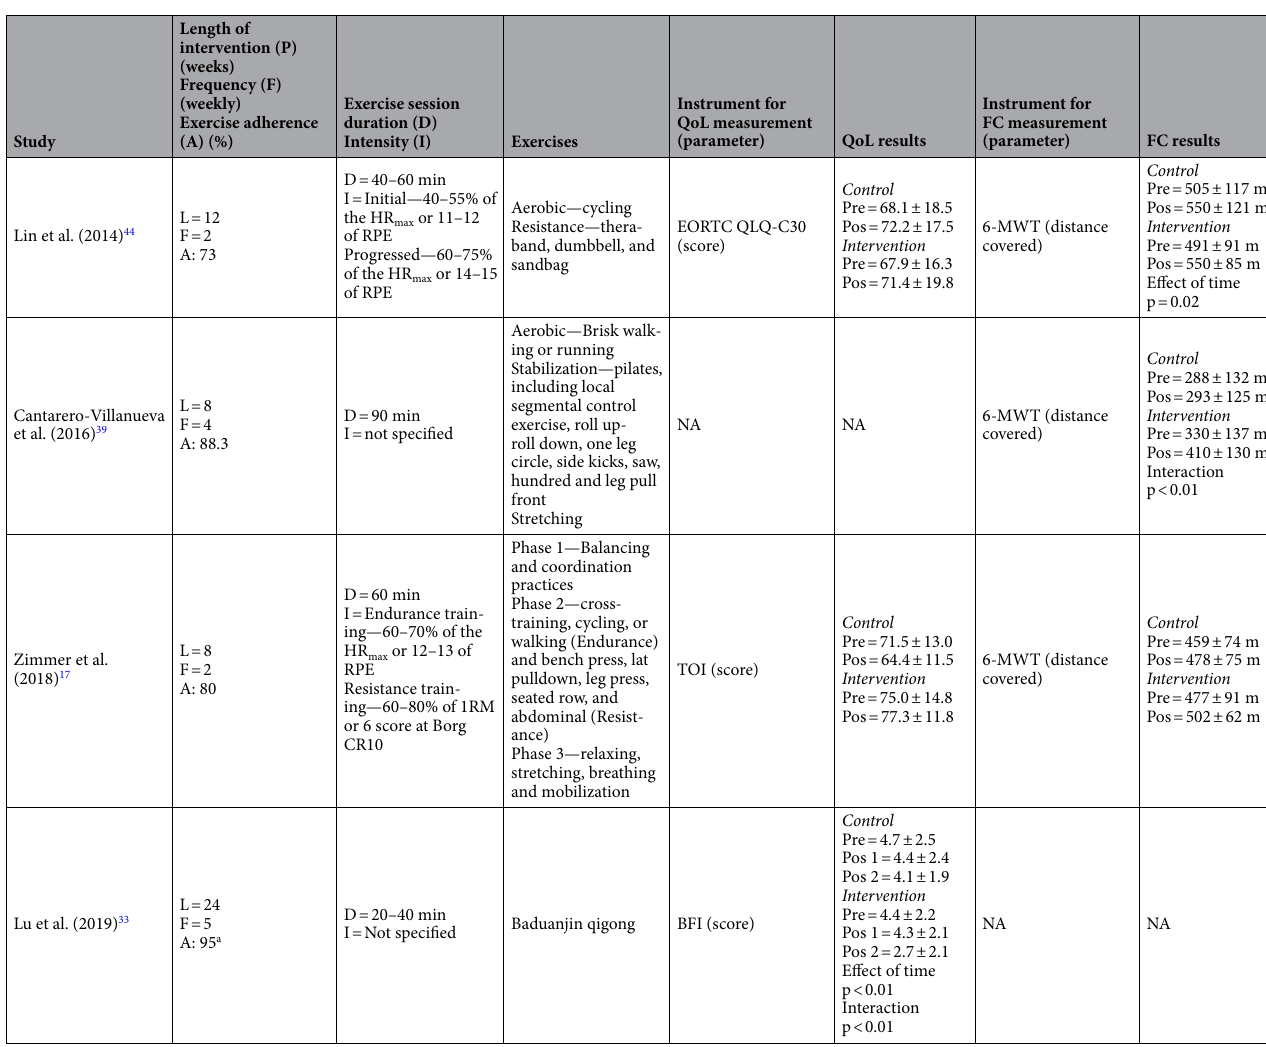
Table 4. Studies design and Quality of Life (QoL) and Functional Capacity (FC) outcomes of supervised exercise interventions in colorectal patients. The EORTC QLQ-C30 provides several outcomes related to the quality of life. Therefore, we opted to expose those who were modified by the intervention; Pos 1—reevaluation at the 12th week; Pos 2—reevaluation at the 24th. EORTC QLQ-C30 European Organization for Research and Treatment of Cancer Quality of Life Core Questionnaire, 6-MWT 6 Minute Walk Test, TOI Trial Outcome Index, RPE Rating of perceived exertion, HR max Maximum Heart Rate, 1RM one maximum repetition, Borg CR10 Borg’s category ratio-scale, BFI Brief Fatigue Inventory. a Retention